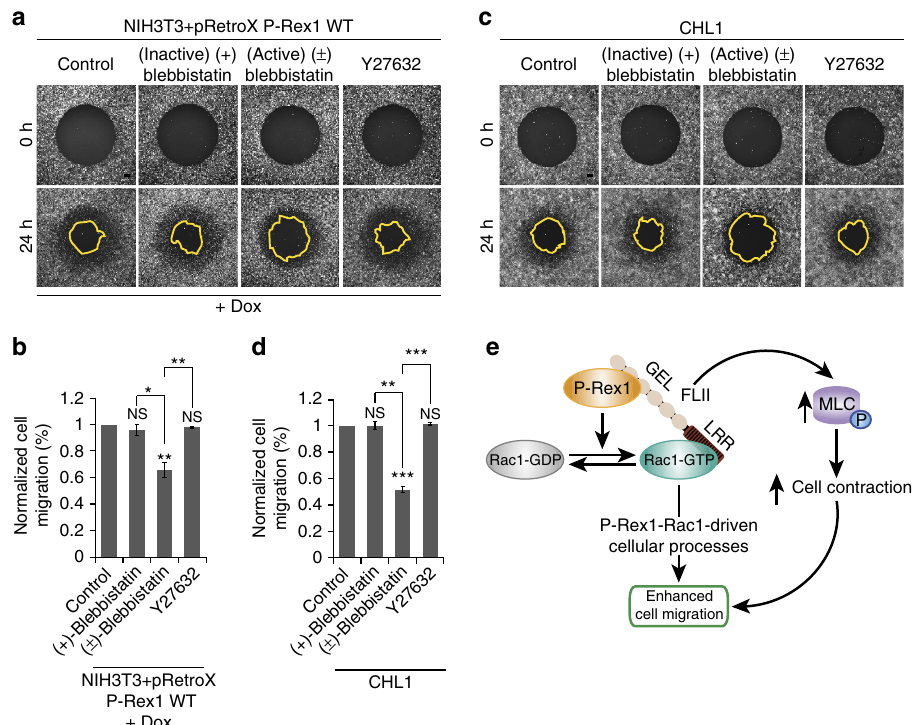
Figure 8 | RhoA-ROCK-independent cell contraction is required for P-Rex1-Rac1-FLII-driven cell migration. ( a ) Representative fluorescence images following Oris migration assay of NIH3T3 cells either left untreated (control), or treated with 100 m M inactive enantiomer of blebbistatin [( þ ) blebbistatin], 100 m M blebbistatin [( ± ) blebbistatin] or 10 m M ROCK inhibitor (Y27632) in the presence of 1 m gml (cid:2) 1 doxycycline ( þ dox) to induce expression of P-Rex1 WT. Scale bar, 200 m m. ( b ) Quantification of cell migration of NIH3T3 cells described in a normalized to control cells. ( c ) Representative fluorescence images following Oris migration assay of CHL1 cells either left untreated (control) or treated with indicated chemicals.